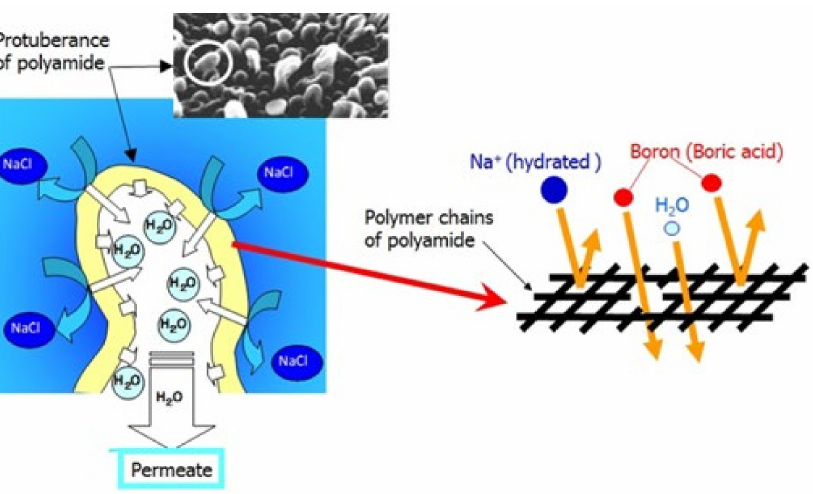
Figure 8. Schematic diagram of salt removal and water permeation through the protuberance [15,20,21].